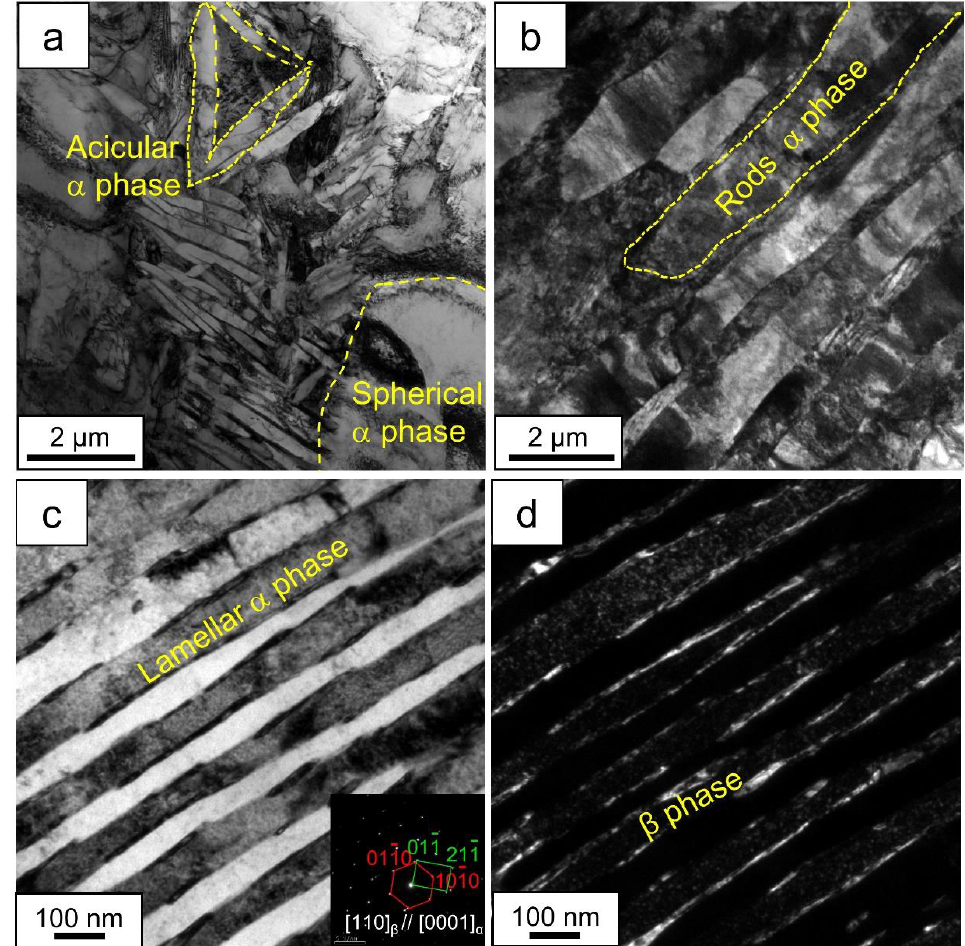
Figure 4. TEM images showing the microstructure features of the hot-rolled LD-Ti423 alloy. ( a – c ) ( a – c ) bright field images showing different types of α phases; ( d ) dark field image showing the bright field images showing different types of α phase s; ( d ) dark field image showing the morphol- ogy of β phases . morphology of β